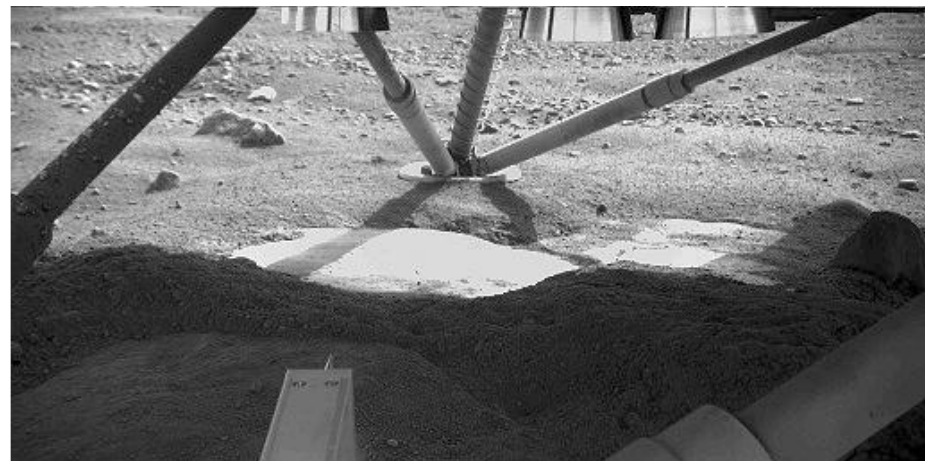
Figure 18. View underneath Phoenix lander showing water ice exposed by the landing retrorockets.